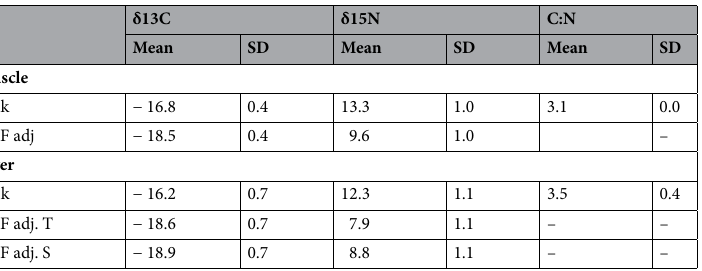
Table 1. Mean (SD) δ 13 C and δ 15 N for Cookiecutter shark tissues (bulk: lipid and urea extracted samples), and tissues adjusted down one trophic level to account for trophic discrimination factors (TDF). Liver samples were adjusted based on TDFs from Tilapia (T) and squid (S) diets (see “Methods”).